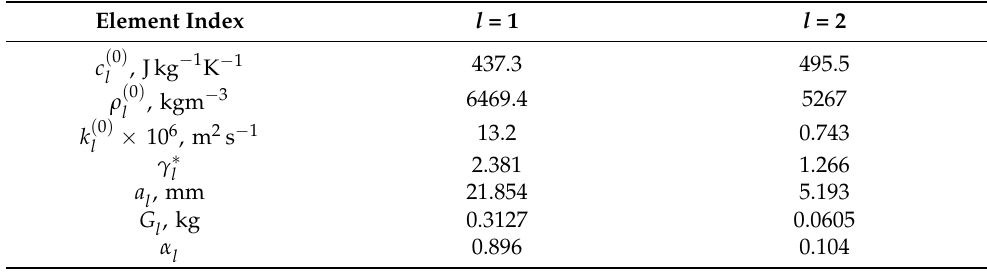
Table 3. Calculated parameters at the initial temperature T 0